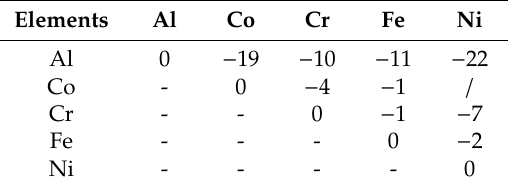
of atom pairs in the Al 0.5 CoCrFeNi HEAs (kJ / mol) [23]. ( ab )